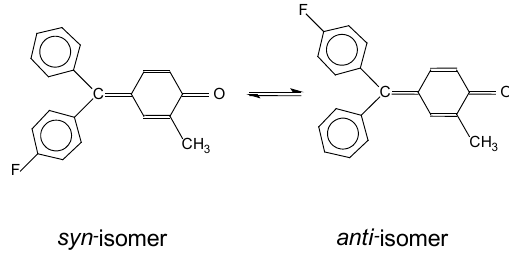
Figure 3. Syn- and anti-isomers as illustrated by 10